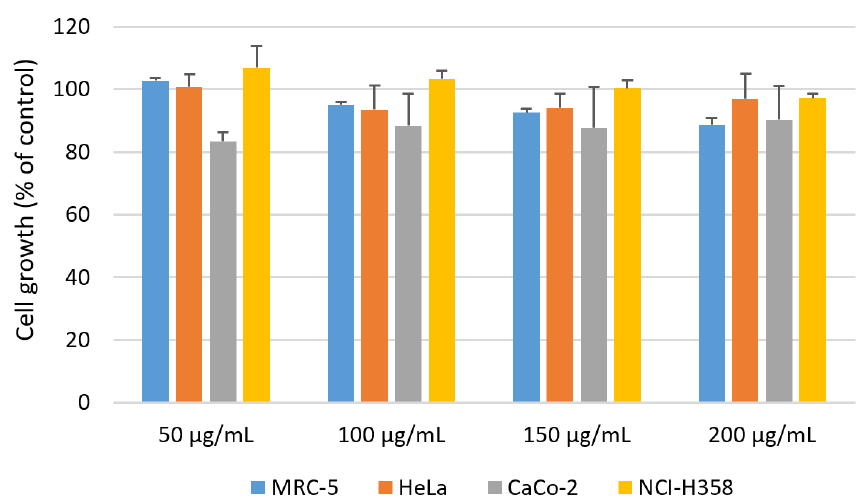
Figure 13. The growth-inhibition effect in vitro of CQD@Leu on selected tumor and non-tumor cell lines. Data represents mean values ± standard deviation (SD) of three independent experiments.